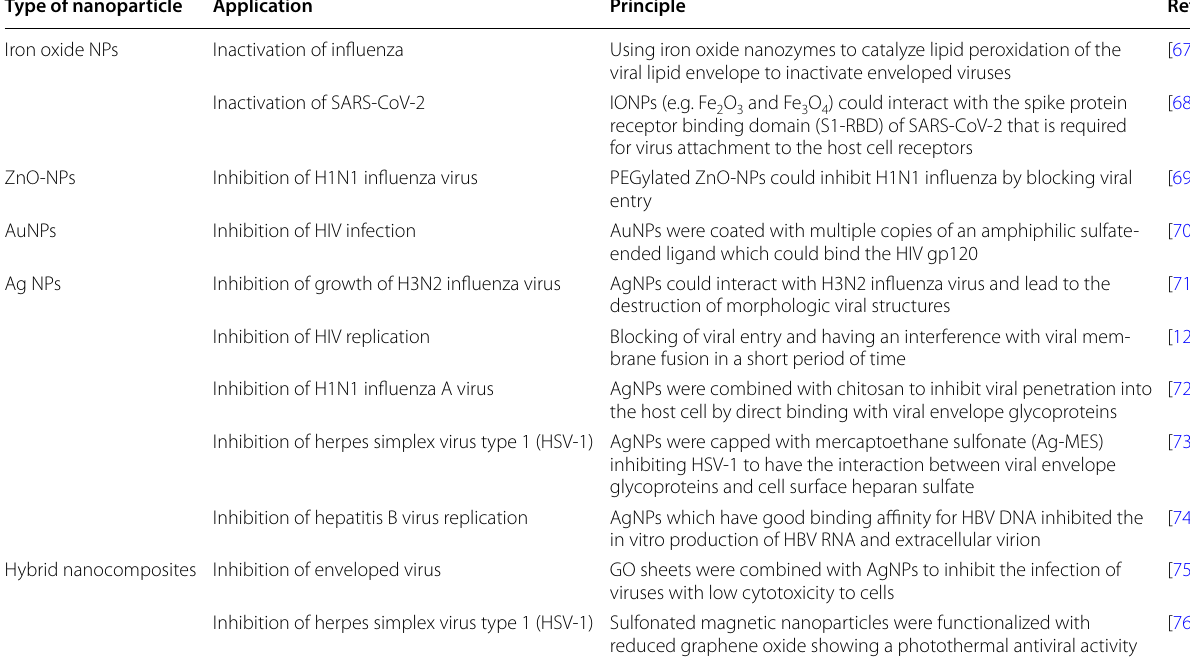
Table 3 Various nanoparticles which have been applied as antiviral